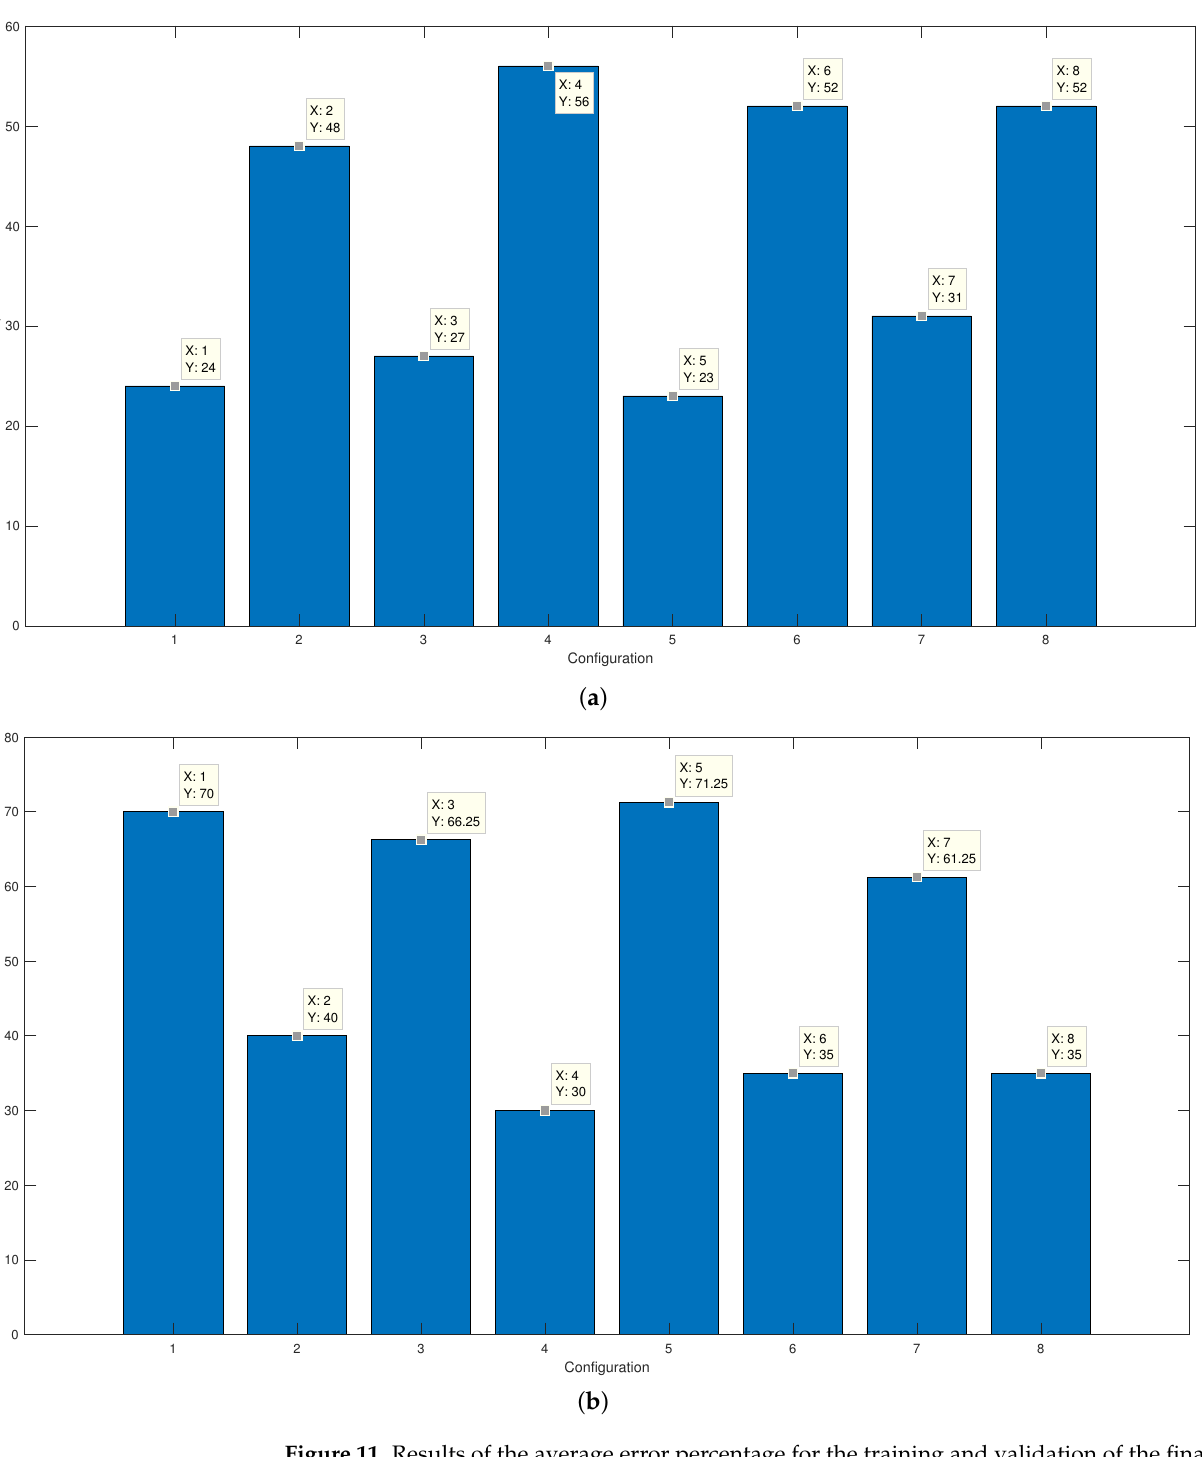
Figure 11. Results of the average error percentage for the training and validation of the final SVM with ( a ) Gaussian kernel and with a ( b ) Linear